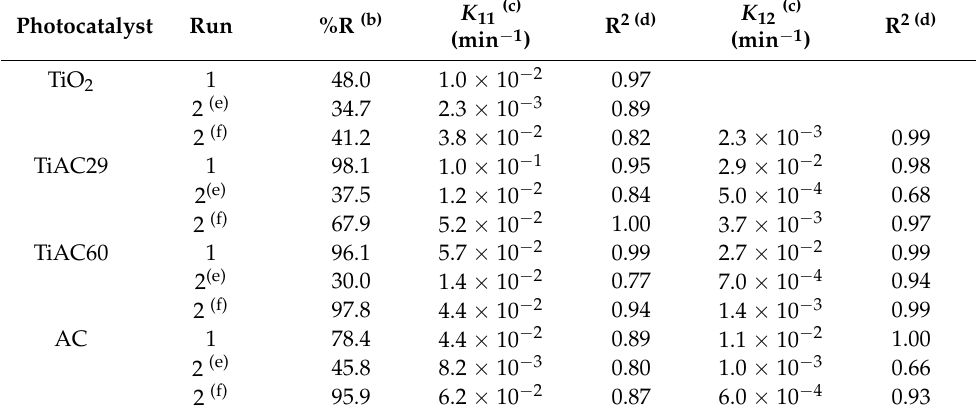
Table 5. Kinetic data from combined adsorption+photocatalytic MB removal from ultra-pure water (a) .